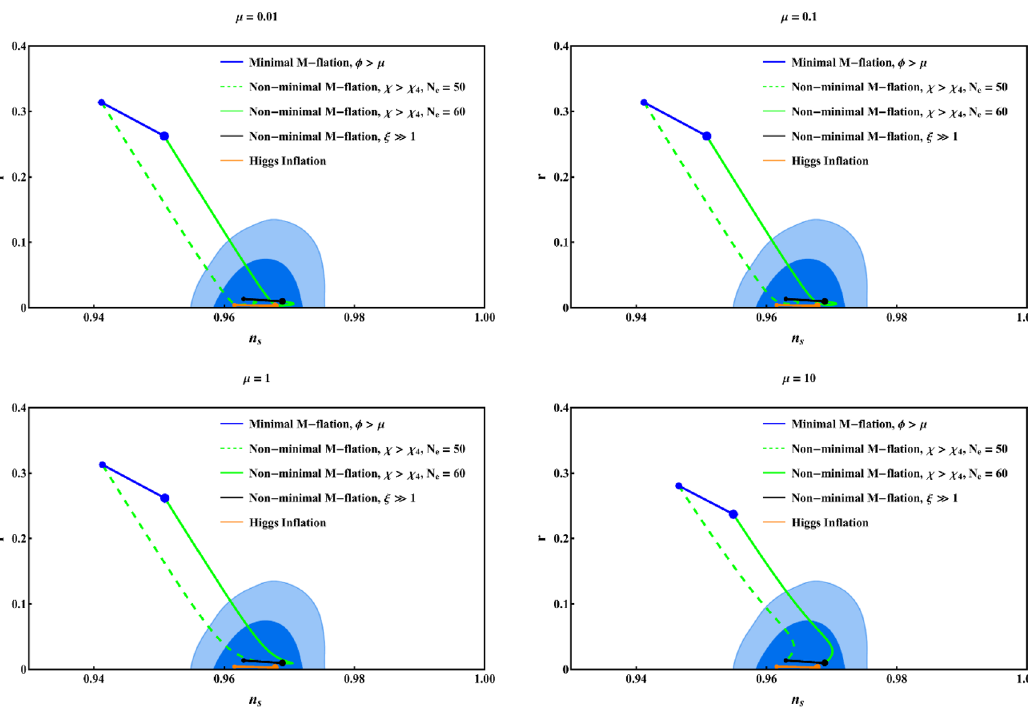
Figure 2 . The predictions of non- M -(cid:13)ation in region (cid:31) > (cid:31) 4 for various values of (cid:22) , symmetry- breaking vev. As (cid:24) increases from zero, the predictions of the model rolls inside the 2 (cid:27) region of PLANCK 2018